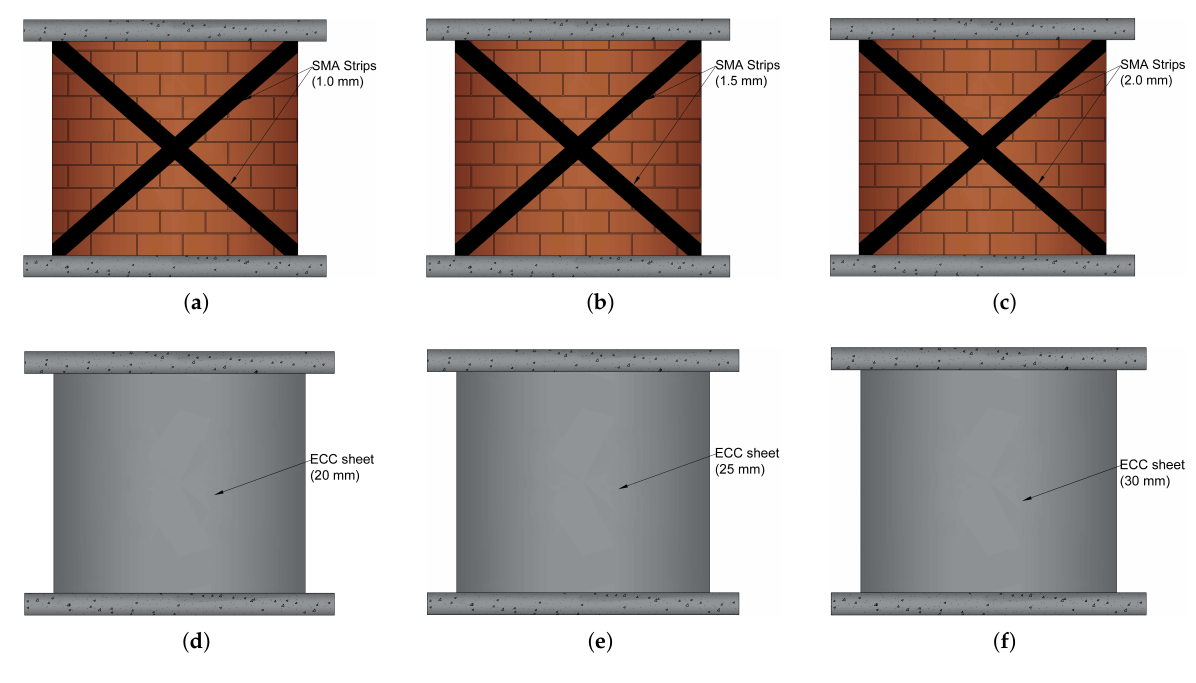
Figure 3. Numerically studied walls; ( a ) URM-SMA-1.0 mm; ( b ) URM-SMA-1.5 mm; ( c ) URM-SMA-